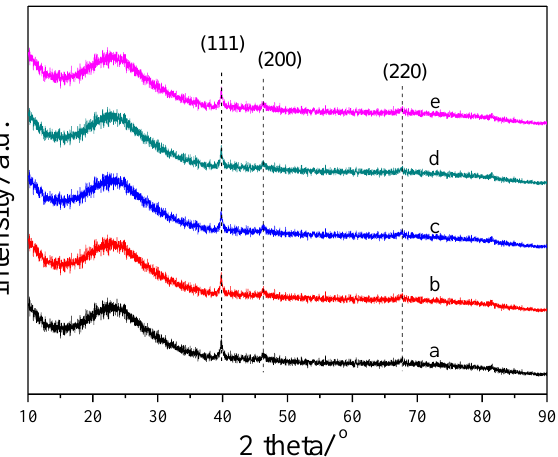
Figure 2. XRD patterns of calcined PtSn/DMSN catalysts with different ratios of Pt and Sn: (a) Pt/DMSN, (b) Pt 1 Sn 1 /DMSN, (c) Pt 1 Sn 2 /DMSN, (d) Pt 1 Sn 3 /DMSN, (e) Pt 1 Sn 4 /DMSN.